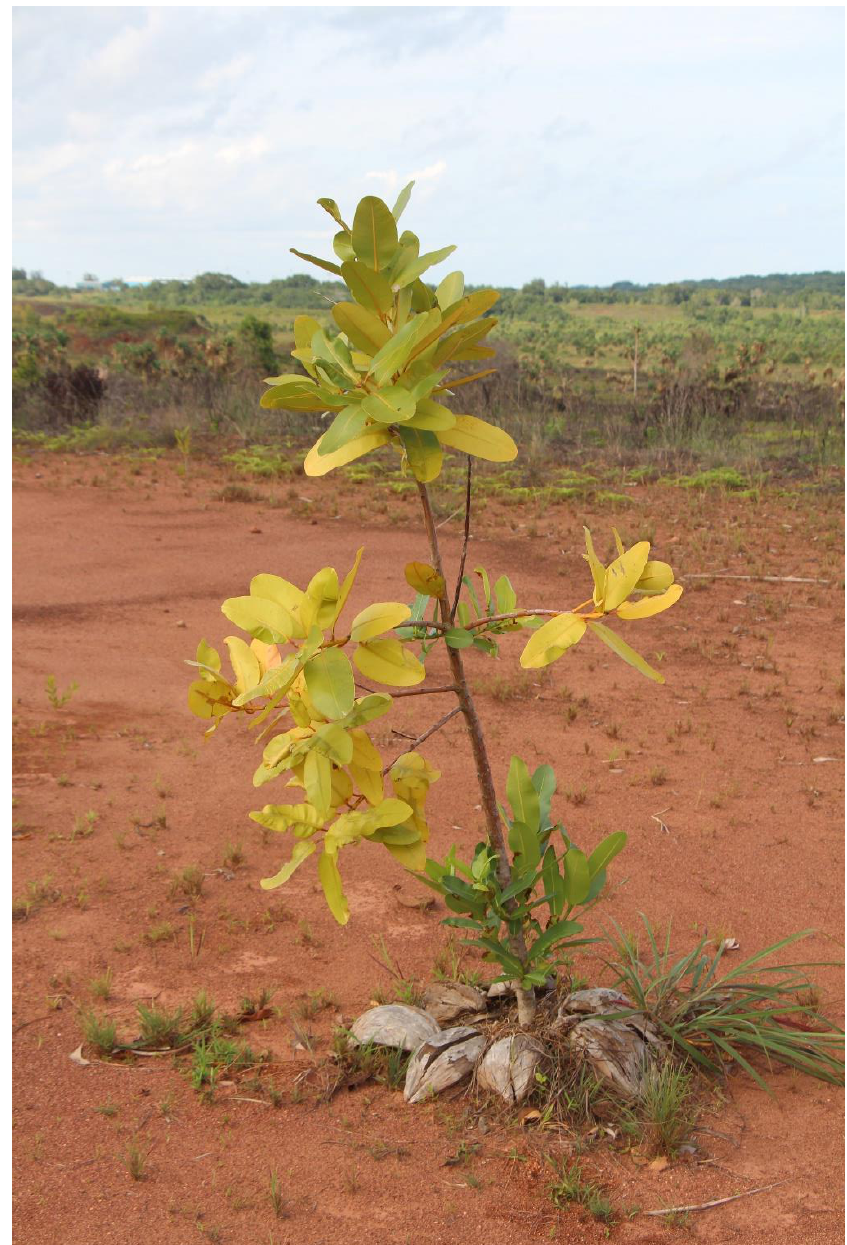
Figure 3. Chlorotic Calophyllum inophyllum seedling in an Oxisol on Yap, Federated States of Micronesia. Treatments for each project included the island’s standard practices compared with other treatments that were chosen based on local ideas and locally available